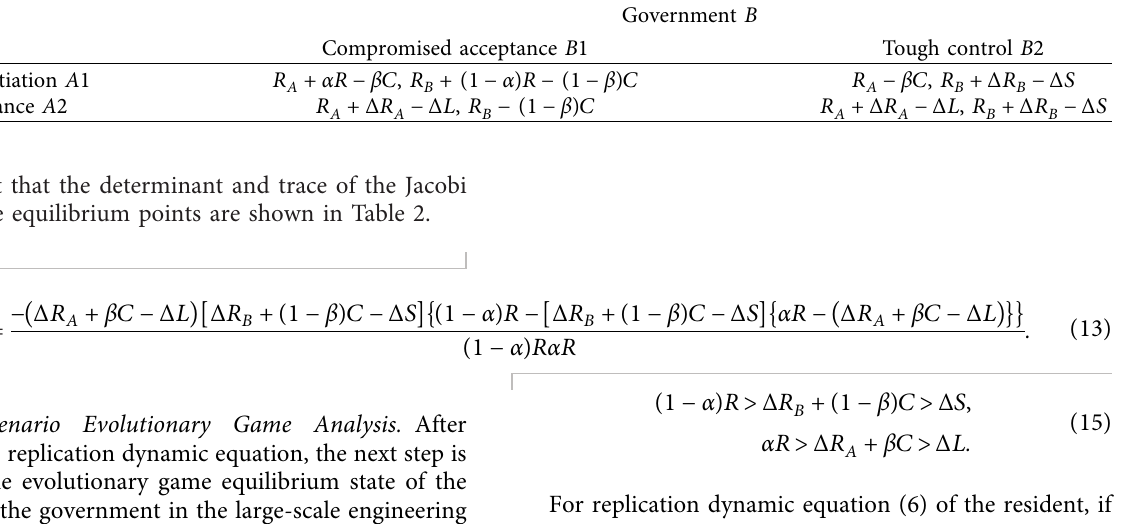
Table 1: The payoff matrix of the evolutionary game between the resident and the